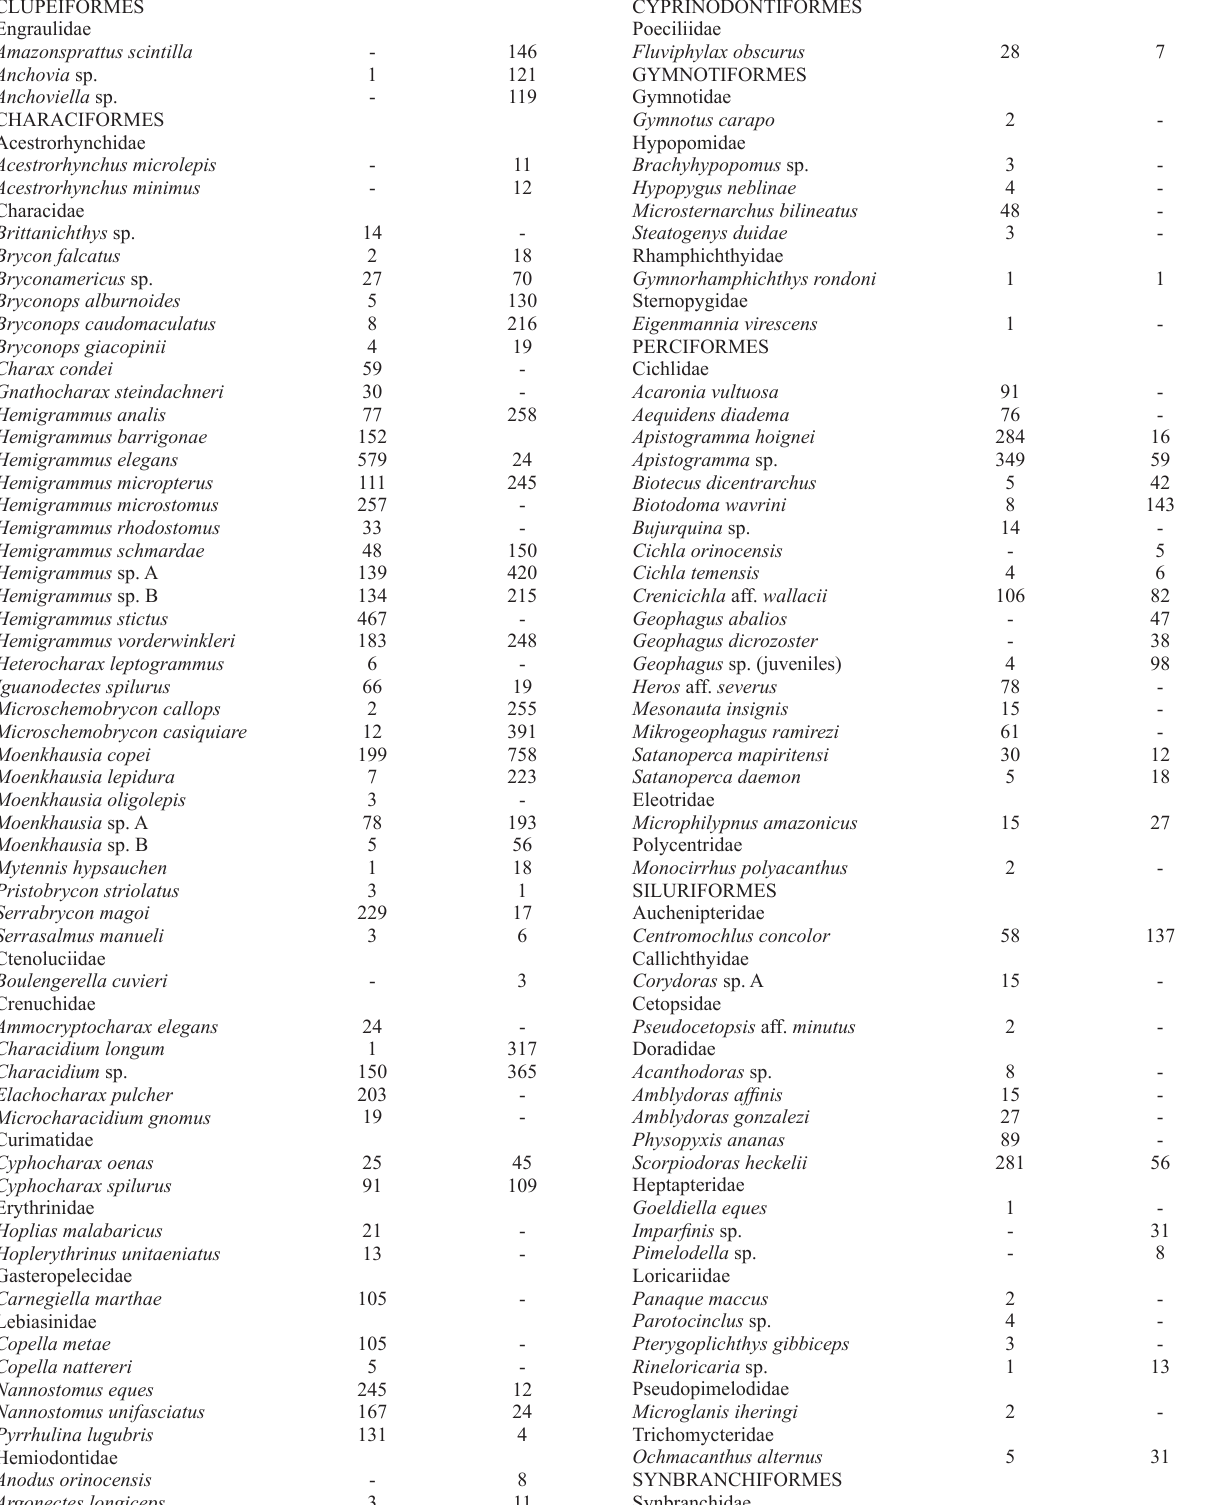
Table 1. Species list with the total of individuals caught for each littoral habitat in Caño La Guardia during the dry season. Order/Family/Genus species Flooded vegetated Engraulidae Amazonsprattus